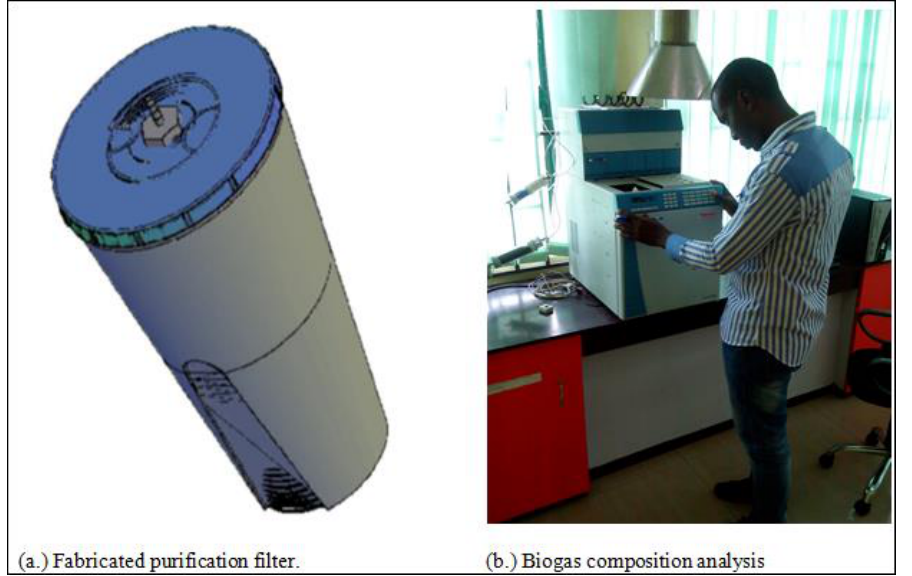
Fig. 5. Fabricated purification filter and biogas composition